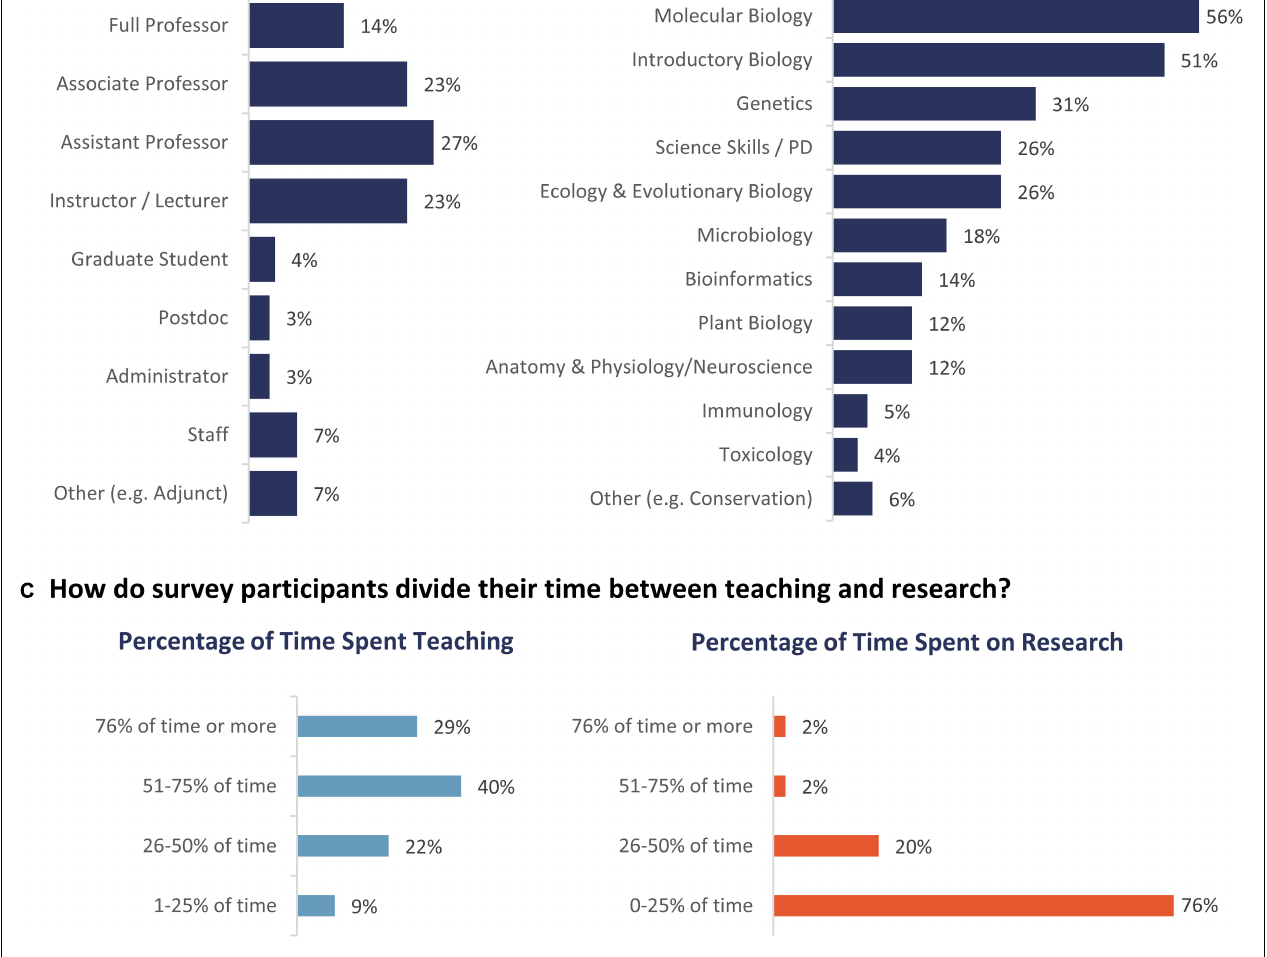
FIGURE 1 | Survey participants’ demographic information based on: (A) Carnegie classification and Minority Serving Institution (MSI) type, (B) academic position and area of biological expertise, and (C) percentage of time spent on teaching and research. The abbreviation PD stands for Professional Development.